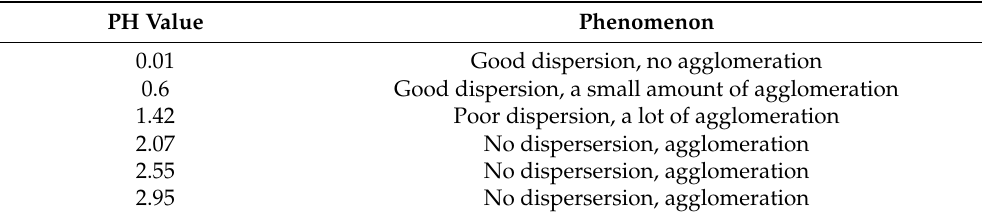
Table 1. The disperse phenomenon of sodium alginate powder in acid solution with different pH values. PH Value Phenomenon 0.01 Good dispersion, no agglomeration 0.6 Good dispersion, a small amount of